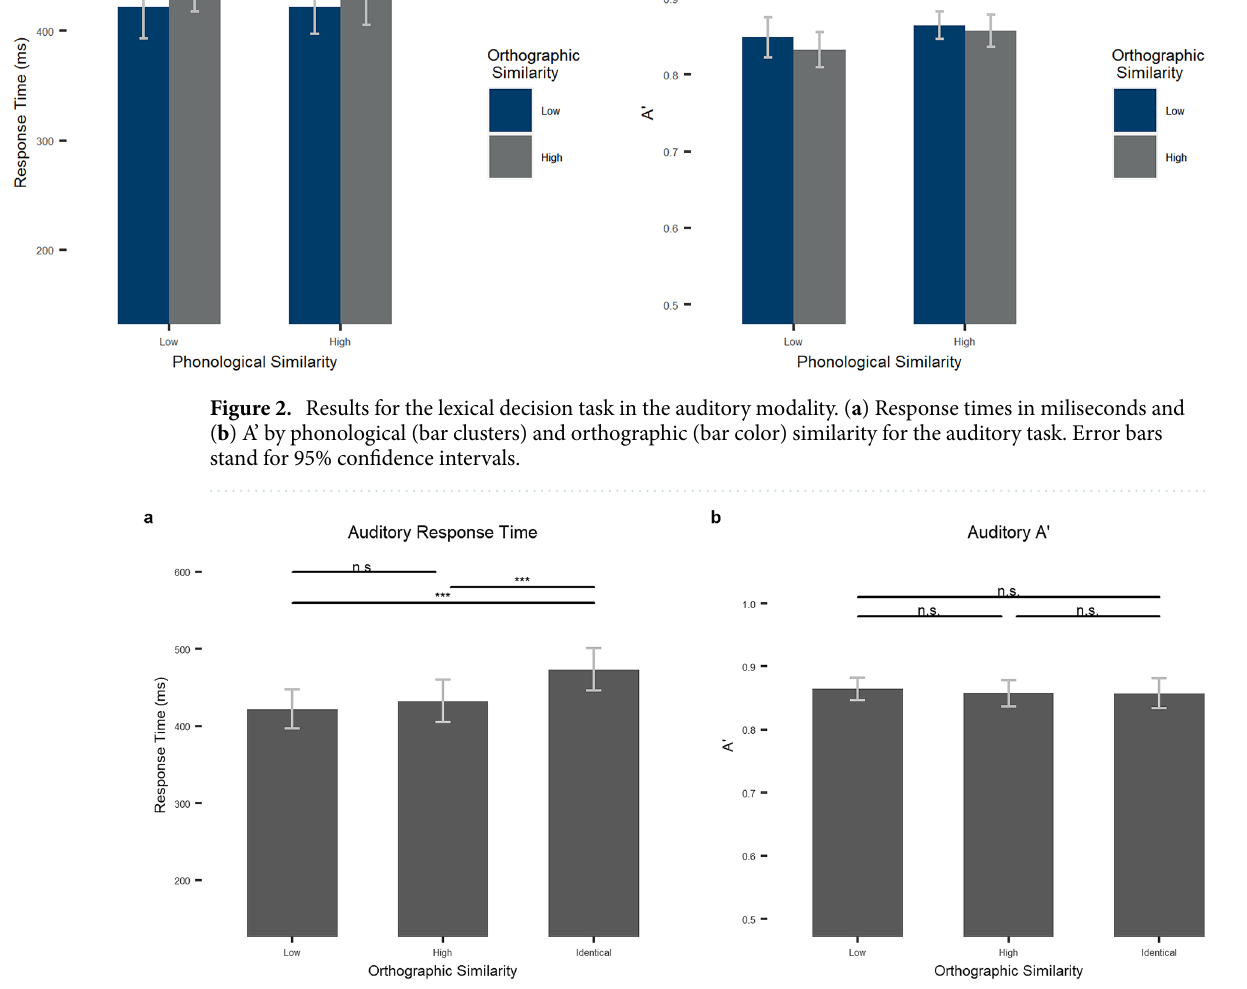
Figure 3. The effects of orthographic similarity on the lexical decision task in the auditory modality. ( a ) Response times in miliseconds and ( b ) A’ by orthographic similarity (low, high, and identical) for the auditory task. Error bars stand for 95% confidence intervals. N.s.: p > .1; + : p < .1; *: p < .05; **: p < .01, ***: p <